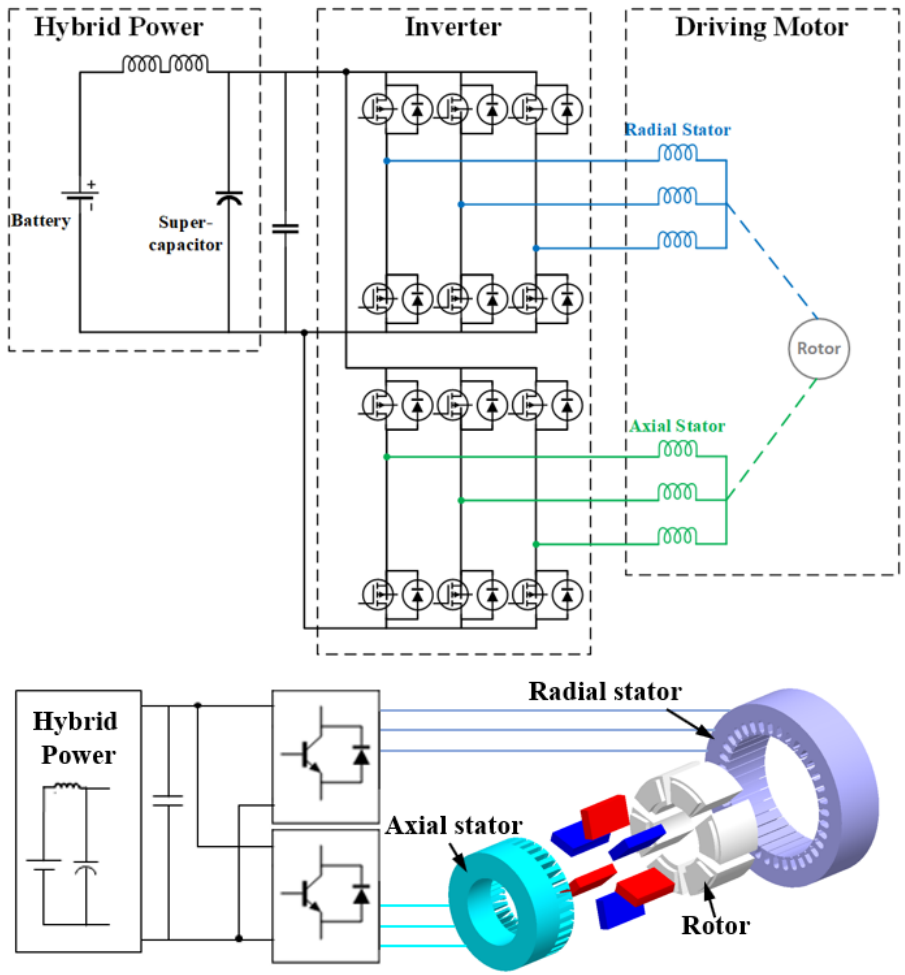
Figure 2. Diagram of driving mode.